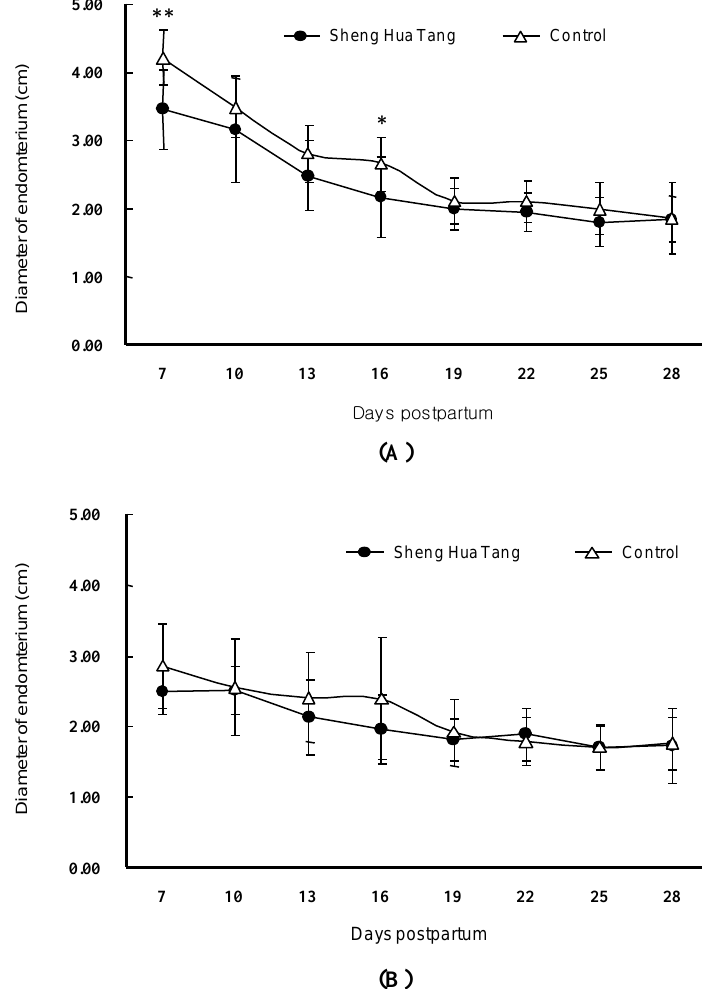
Figure 3. Effects of Sheng Hua Tang treatment on involutionary progress curves for endometrial diameter of uterine horn in postpartum dairy cows. Means  SE (n = 10). (A) The endometrial diameter of gravid uterine horn was obviously reduced in the Sheng Hua Tang- receiving group than the control group on the 7th and 16th d postpartum. * Means differ significantly between groups (p<0.05); ** Means differ significantly between groups (p<0.01); (B) The endometrial diameter of nongravid uterine horn, there were no significant differences in both experimental and control